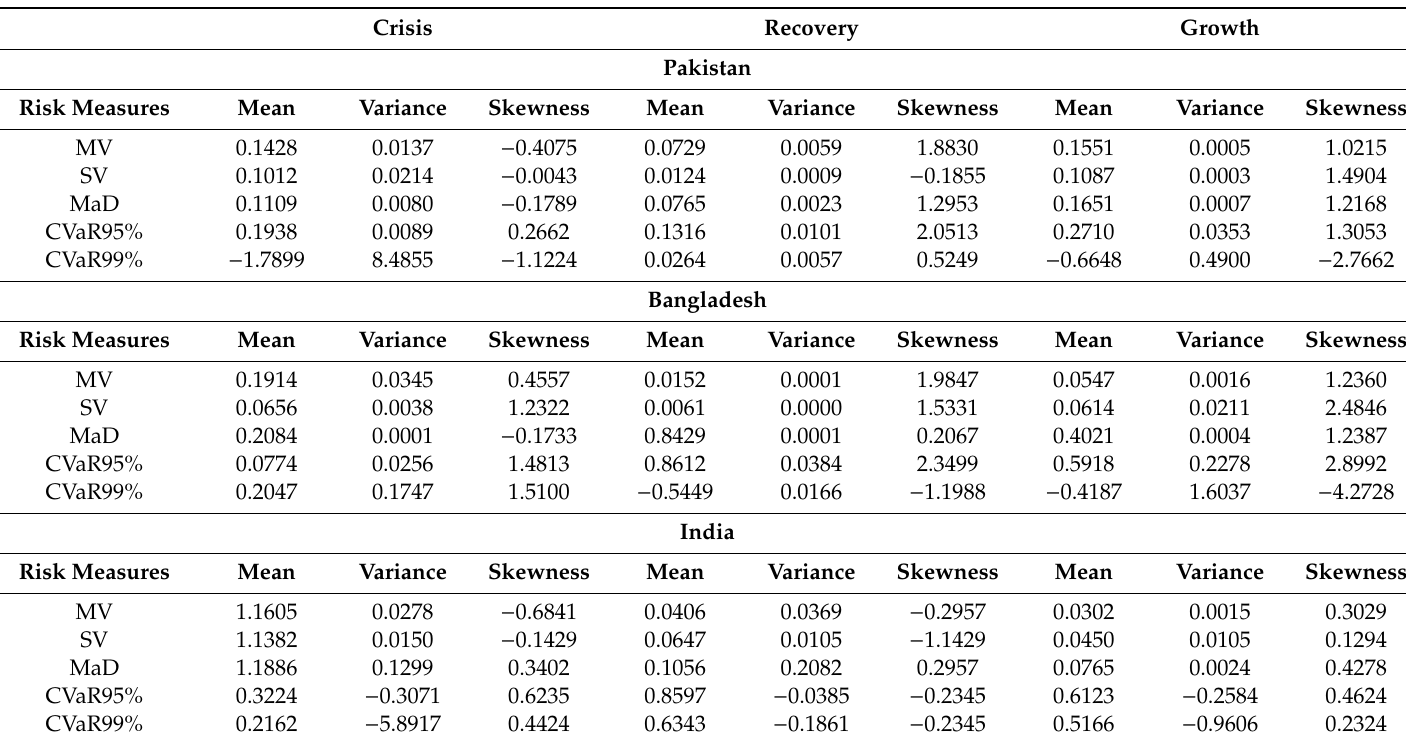
Table A1. Summary Statistics of Optimal